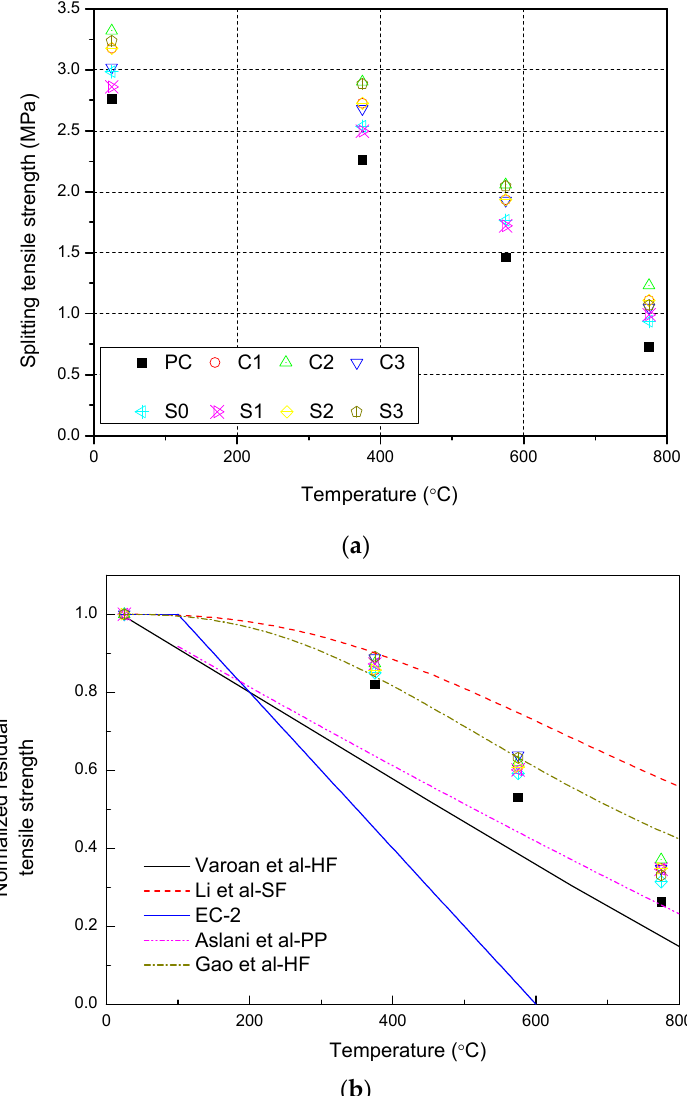
Figure 5. Evolution of the NSCFRC tensile strength at high temperatures: ( a ) The residual tensile strength after exposure to high temperature; ( b ) The normalized residual tensile strength after exposure to high temperature.